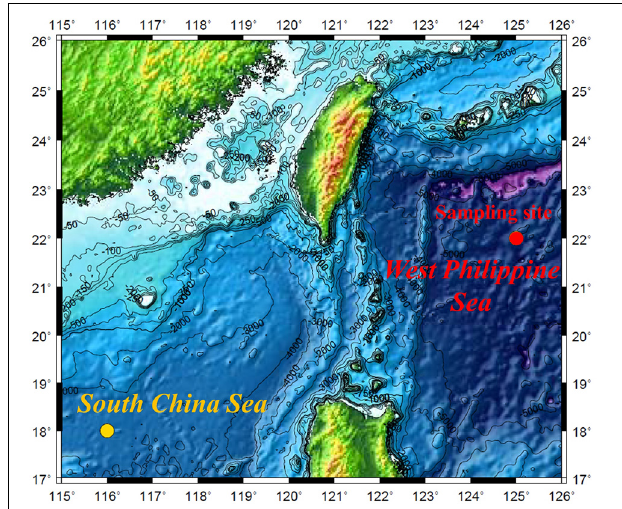
FIGURE 1 | Location of the sampling site in the West Philippine Sea. The study site of Yang et al. (2012) in the South China Sea is also presented.